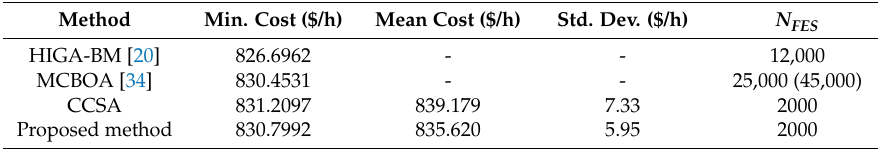
Table 7. The result comparison for subcase 3.2.